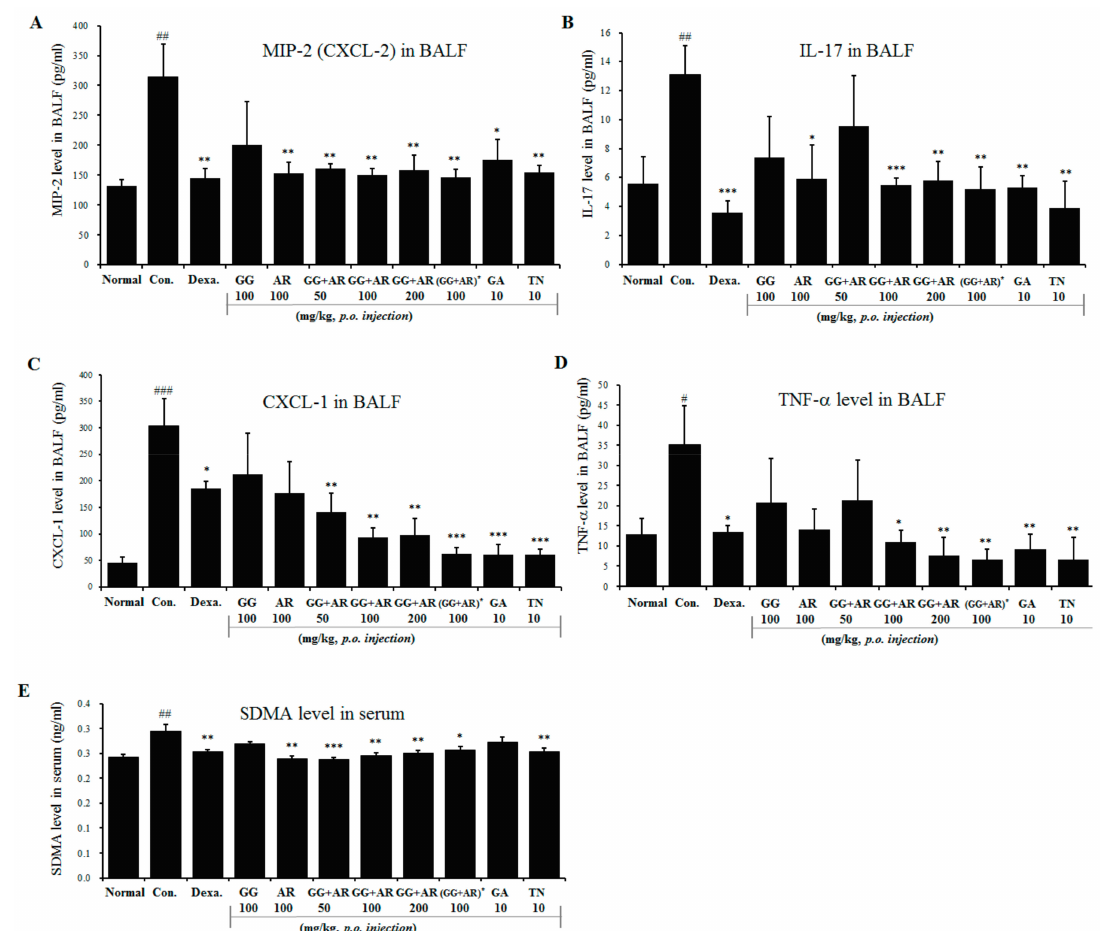
Figure 4. E ff ect of GG, AR, GG plus AR, GA, and TN on CXCL2, IL-17A, CXCL1, and TNF- α in BALF and SDMA production in serum of COPD model mice. Mice were challenged by intratracheal injection of CFD, and then treated with GG, AR, GG plus AR, GA, and TN over a period of 12 days. The levels of CXCL2 ( A ), IL-17A ( B ), CXCL1 ( C ), and TNF- α ( D ) in BAL fluid and SDMA ( E ) in serum were determined by ELISA. Normal: normal group; Con.: CFD, CFD-induced COPD model group; Dexa.: CFD solution and administrated with dexamethasone 3 mg / kg group; GG 100: CFD solution and administrated with GG extract 100 mg / kg group; AR 100: CFD solution and administrated with AR extract 100 mg / kg group; GG + AR 50: CFD solution and administrated with GG plus AR extract 50 mg / kg group; GG + AR 100: CFD solution and administrated with GG plus AR extract 100 mg / kg group; GG + AR 200: CFD solution and administrated with GG plus AR extract 200 mg / kg group; GG + AR 100*(trial product): CFD solution and administrated with GG plus AR (trial product) 100 mg / kg group; GA 10: CFD solution and administrated with GA 10 mg / kg group; TN 10: CFD solution and administrated with TN 10 mg / kg group. The statistical significance of di ff erences between control and treatment groups were assessed by ANOVA and Duncan’s multiple comparison test. Data represent the mean ± SEM of 8 independent experiments. (# P < 0.05, ## P < 0.01, ### P < 0.001, significantly di ff erent from the value of normal group. * P < 0.05, ** P < 0.01, and *** P < 0.001 significantly di ff erent from the value of control